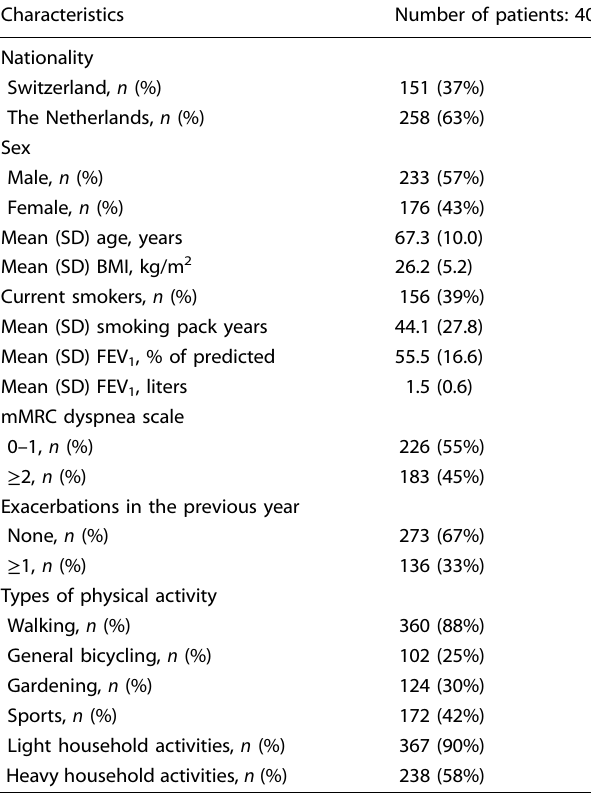
Table 1. Baseline characteristics of study patients Characteristics Number of patients: 409